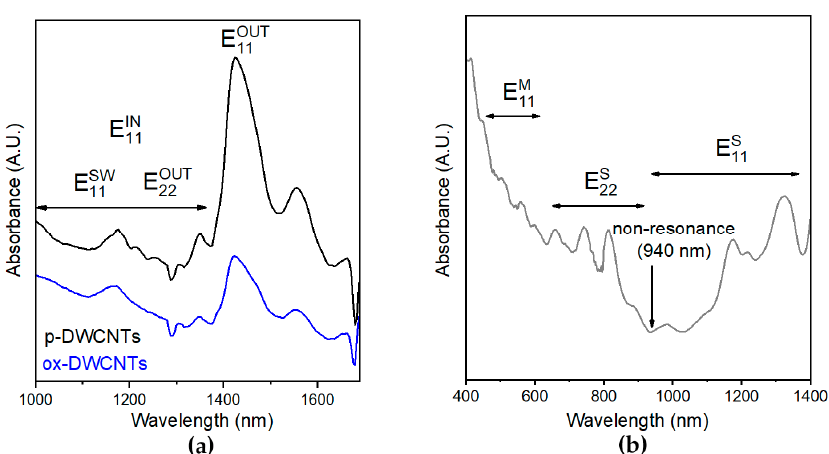
Figure 2. Absorbance spectra of CNTs. ( a ) NIR spectra of pristine (p-) and oxidized (ox-) DWCNTs. ( b ) Vis-NIR spectrum of untreated SWCNTs.